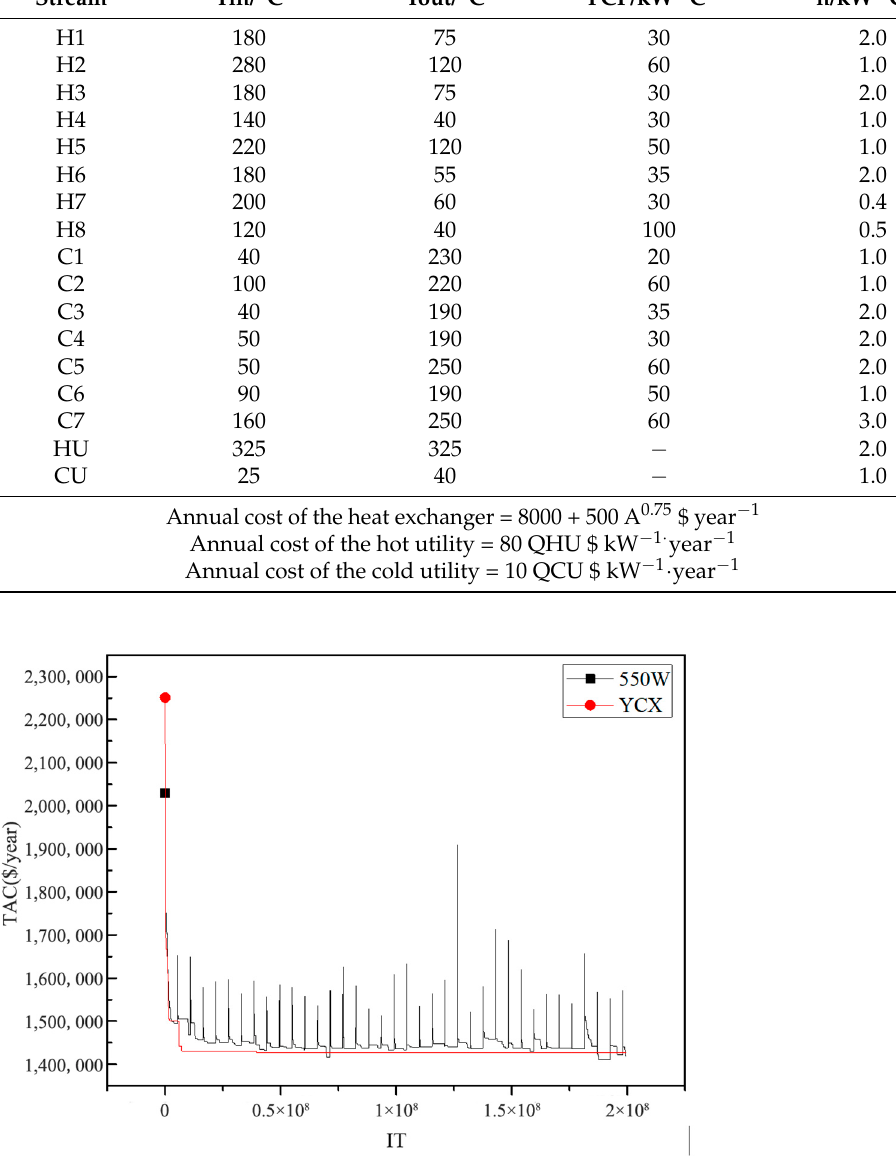
Figure 4. Timely TAC curve and the best TAC curve obtained through the participatory evolutionary strategy.